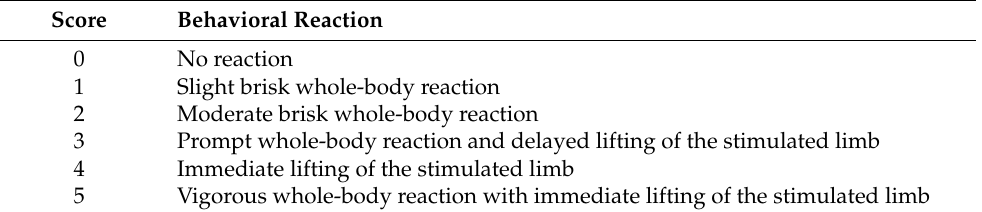
Table 1. Scoring system for behavioral reactions during stimulation (modified from Rohrbach et al., 2009